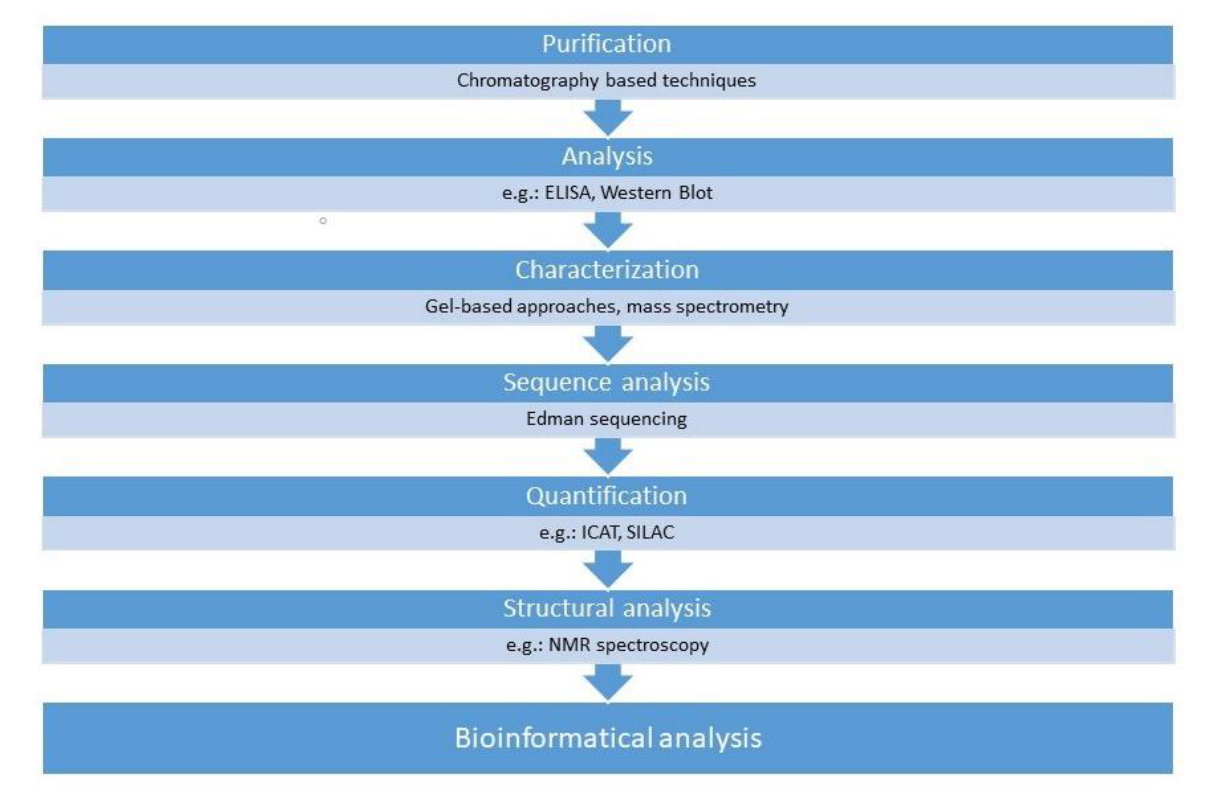
Figure 2. Application of different proteomics technologies. ELISA, enzyme-linked immunosorbent assay (ELISA), ICAT, Isotope-coded affinity tag labeling; SILAC, stable isotope labeling with amino acids in cell culture; NMR spectroscopy, nuclear magnetic resonance spectroscopy.